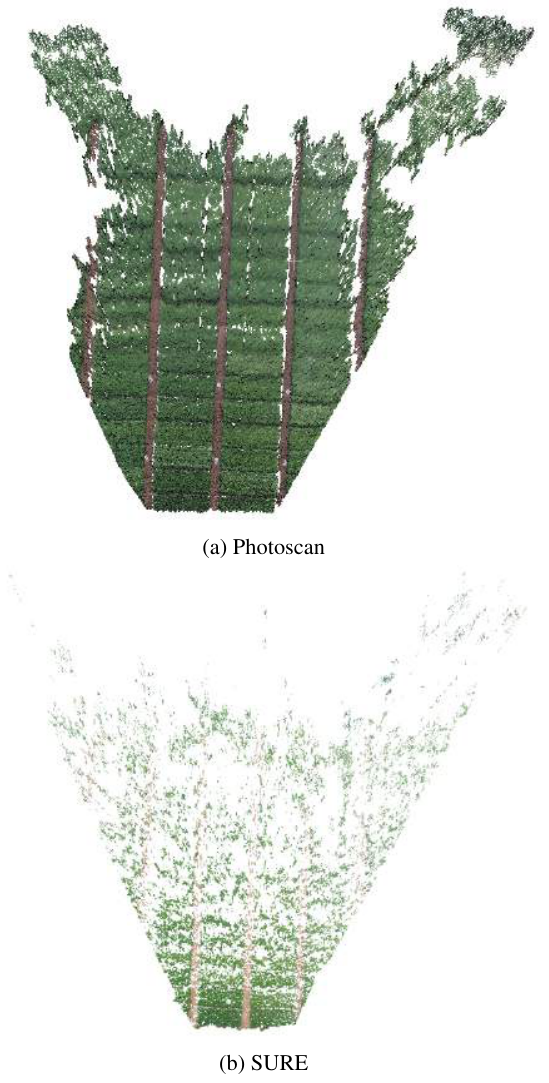
Figure 2. Top-down view of point clouds for the morning of May 08 SURE did not perform as good as Photoscan. For one acquisition date, no point cloud was generated at all, and for two other dates, there were large parts of the field where the point cloud obviously does not represent the crop surface correctly. Compared to the point clouds generated by Photoscan, the point clouds contained noise not seen in the Photoscan point clouds, especially along the borders of the point cloud and at distances of more than 40m